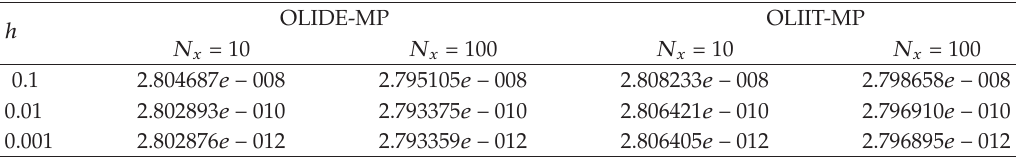
Table 2: The errors (cid:16) at t (cid:5) 10 when the algorithms are applied to the problem (cid:3) 5.6 (cid:4) with the coe ffi cients group I, where τ (cid:3) t (cid:4) (cid:5)